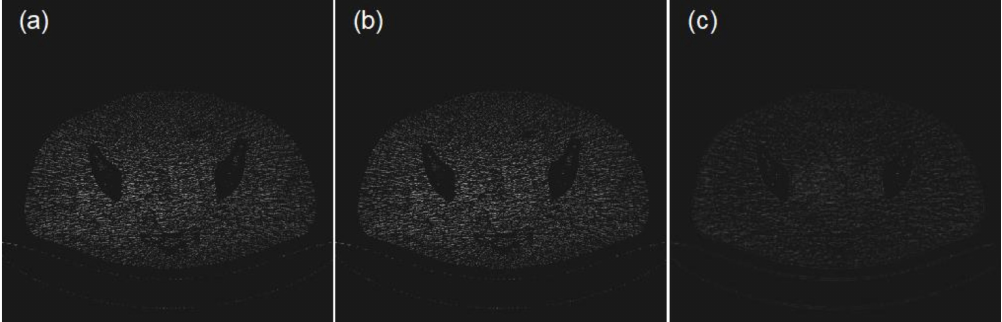
Figure 4. From left to right, ( a – c ) respectively represent the residual image of the LDCT image in Figure 2b, the reconstructed results by the bicubic interpolation in Figure 2c and the method proposed in this paper in Figure 2d.